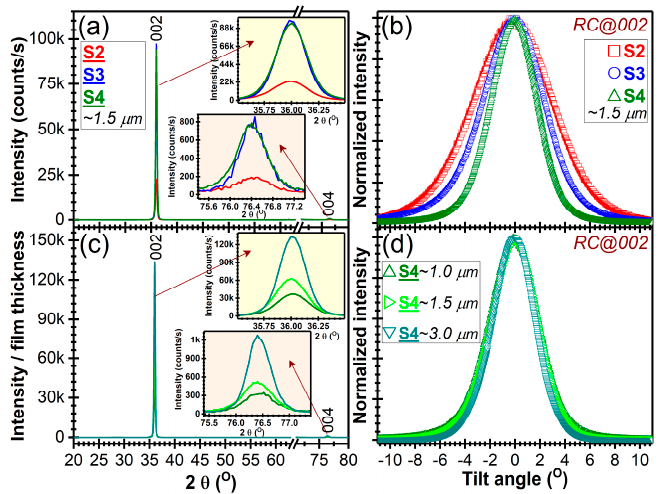
Figure 3. ( a , c ) XRD diagrams recorded in symmetric θ – θ geometry ( b,d ) RCs of the AlN 002 reflections. ( a , b ) Structure quality—base pressure dependence in the case of ~1.5 μ m AlN films ( c , d )